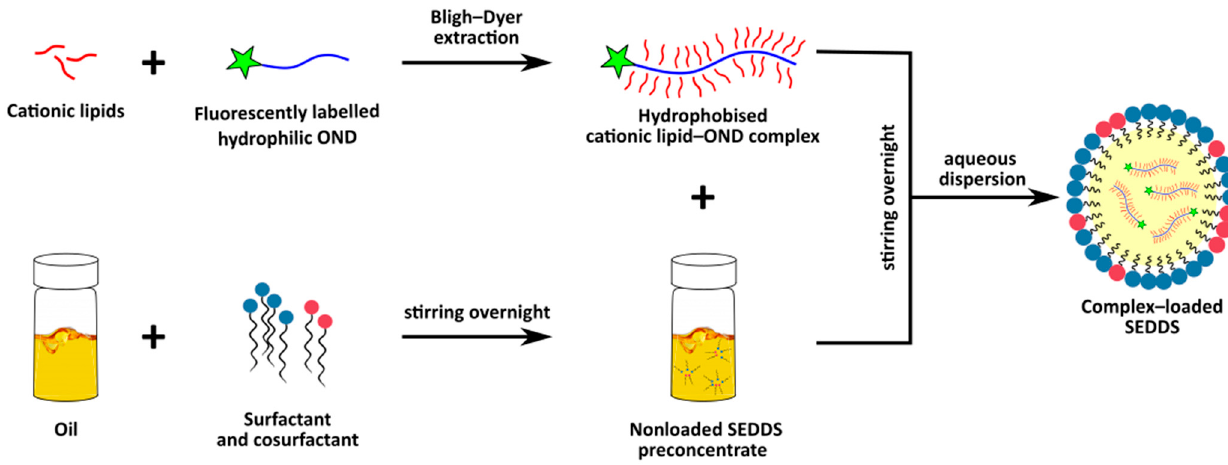
Figure 1. A general scheme showing the formulation of an oligonucleotide (OND) into a self-emulsifying drug delivery system (SEDDS).